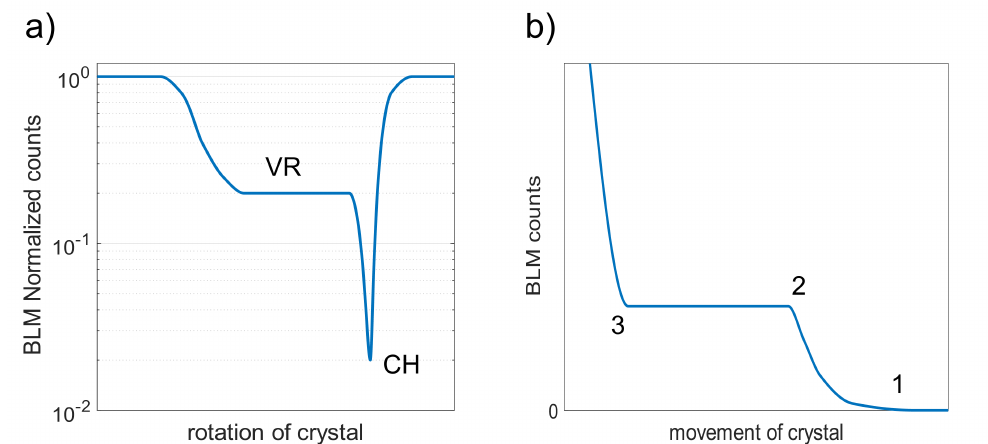
Figure 20. Example of channeling study by monitoring nuclear interactions of the beam using beam loss monitors. ( a ) Signal of the beam loss monitor downstream the crystal during alignment procedure. Decrease in inelastic scattering with crystal is observed during volume reflection (VR) and is finally minimized once in channeling (CH). ( b ) Once in channeling, a collimator is moved to gradually towards the beam. Channeled particle are well localized (between 1 and 2) and no more particle are intercepted until close to main beam